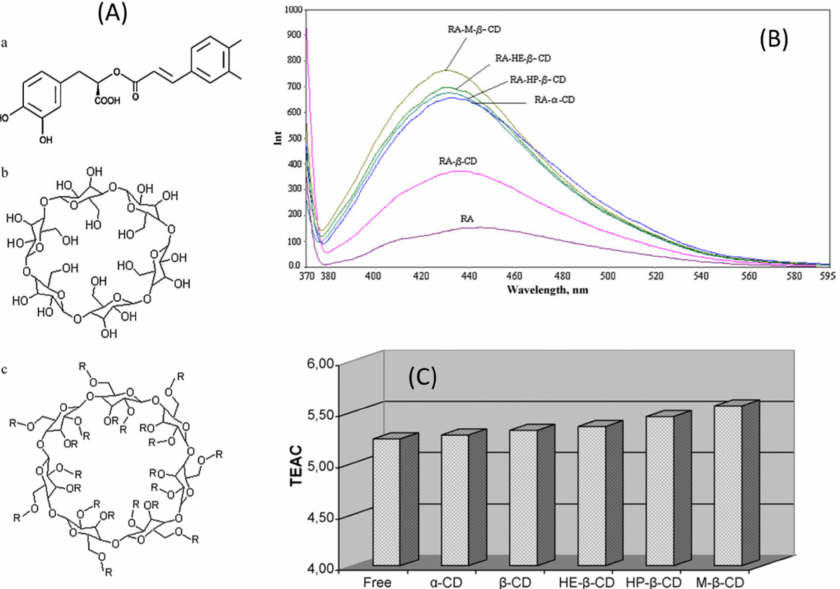
Figure 6. ( A ) Molecular structures of the guest and hosts in RA-CD complexation: ( a ) RA, ( b ) α -CD and ( c ) β -CD (R = H) and its derivatives. ( B ) Fluorescence spectra of RA in aqueous solution with different CDs at pH 7.0. ( C ) Trolox equivalent antioxidant capacity (TEAC) of RA in free and complex forms in aqueous solutions at pH 7.0 (adapted from Celik et al. [111], copyright 2011